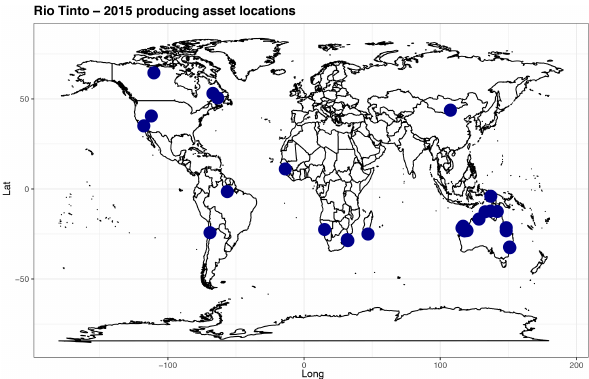
Figure 3. Locations of productive Rio Tinto mining assets at the end of 2015 (some assets overlap on the